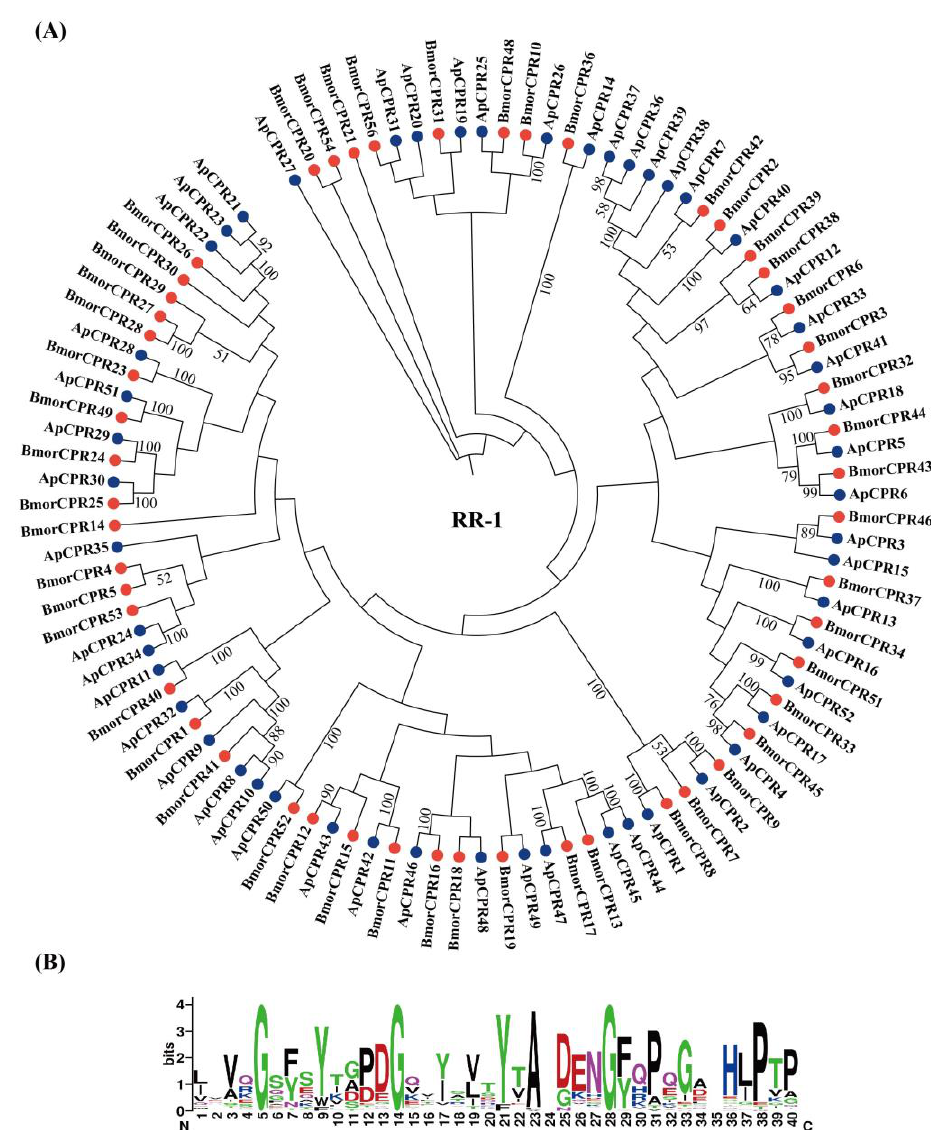
Figure 2. Phylogenetic relationship ( A ) and sequence logo of the conserved region ( B ) of RR-1 proteins from A. pernyi (Ap; blue circle) and B. mori (Bmor; red circle). The sequence logo was generated by Weblogo [34].